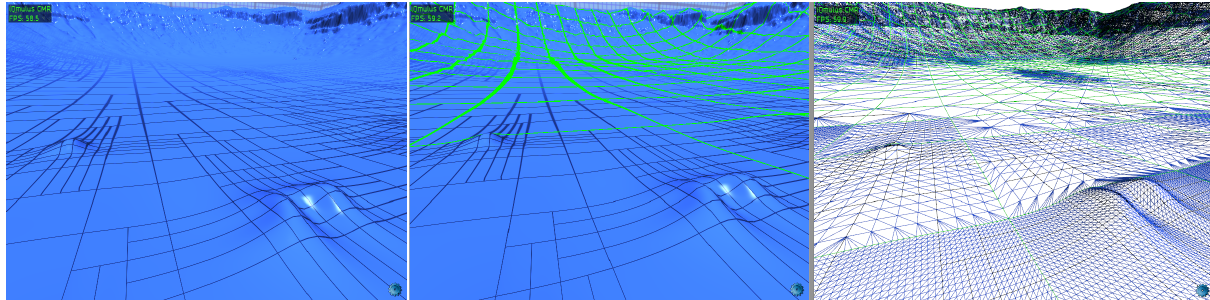
Figure 2: Details illustrating the LR B-Spline rendering technique. The surface consists of a set of elements, outlined in black (left). These elements are rendered using tessellated patches outlined in green (center). The number of triangles used to render each patch varies depending on the screen size of the elements within that patch. The right figure shows an exaggeration of the interactive level of detail, constructed by setting an artificially high error tolerance when computing the number of triangles per patch. Notice that the resulting triangle mesh is water tight. The dataset shown is from the Barringer Crater, Arizona.